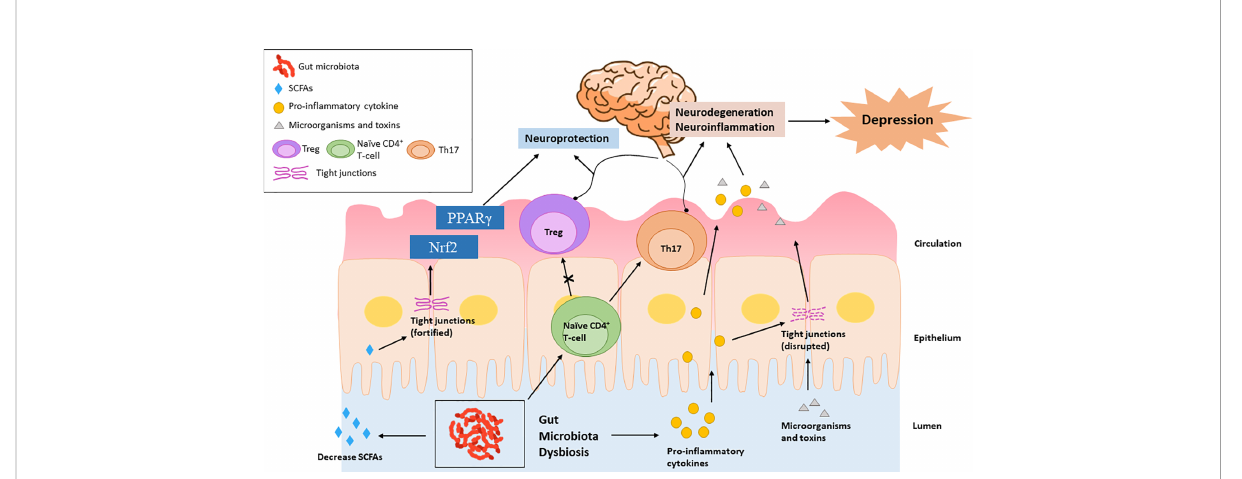
FIGURE 3 Microbiota dysbiosis increases pro-in fl ammatory cytokines, which promote the differentiation of naïve autoreactive CD4 + T-cells in Th17 cells and subsequently cause neurodegeneration. Elevated pro-in fl ammatory cytokines can also impair the tight junctions, leading to the intestinal transport of microorganisms and bacterial toxins, causing neuroin fl ammation. Microbiota dysbiosis decreases SCFAs, which exhibit neuroprotective functions by enhancing the intestinal tight junction and up-regulating the PPAR g and Nrf2 signaling